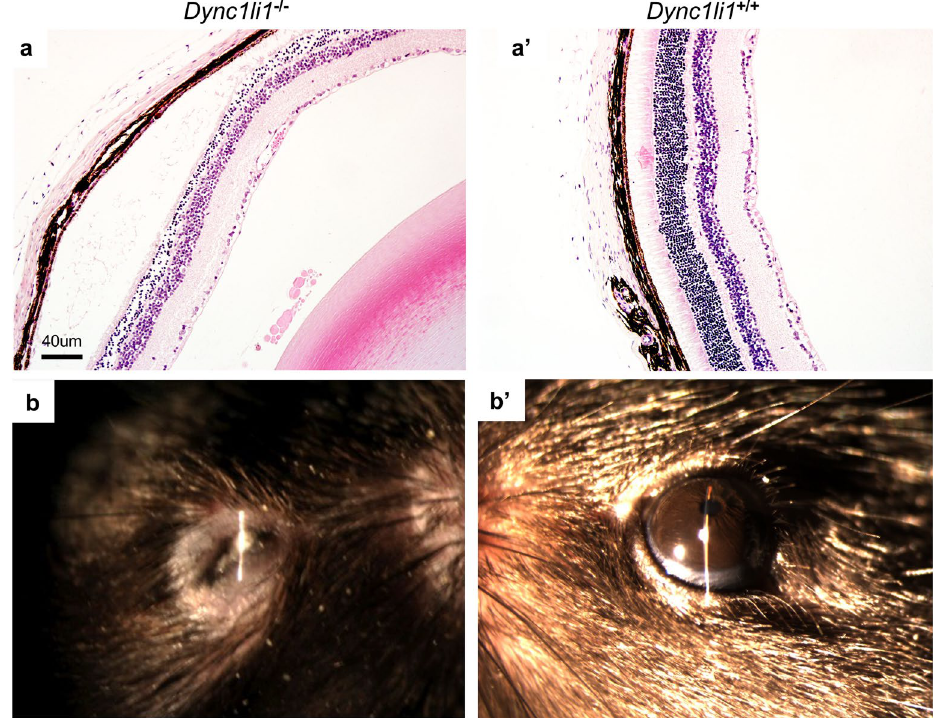
Figure 5. Dync1li1 −/− mice have ocular abnormalities in the retina and microphthalmia. ( a ) Extensive retinal hypoplasia, atrophy, and cellular disorganization across all layers of the retina. In addition, the retina has decreased total thickness compared to control. ( b ) Microphthalmia evident on slit lap examination compared to